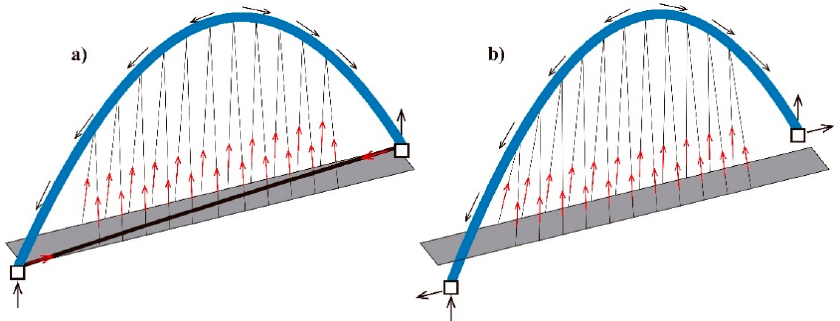
Figure 27. ( a ) Tied DAB and ( b ) detached DAB.